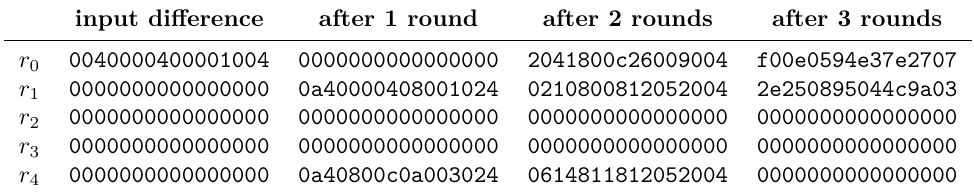
Table 22: Differential characteristic to create forgery for round-reduced Ascon-128a with a 3-round permutation. The differential probability is 2 − 116 . The breakdown of the probability (in − log ) is [8 , 44 , 64] 2